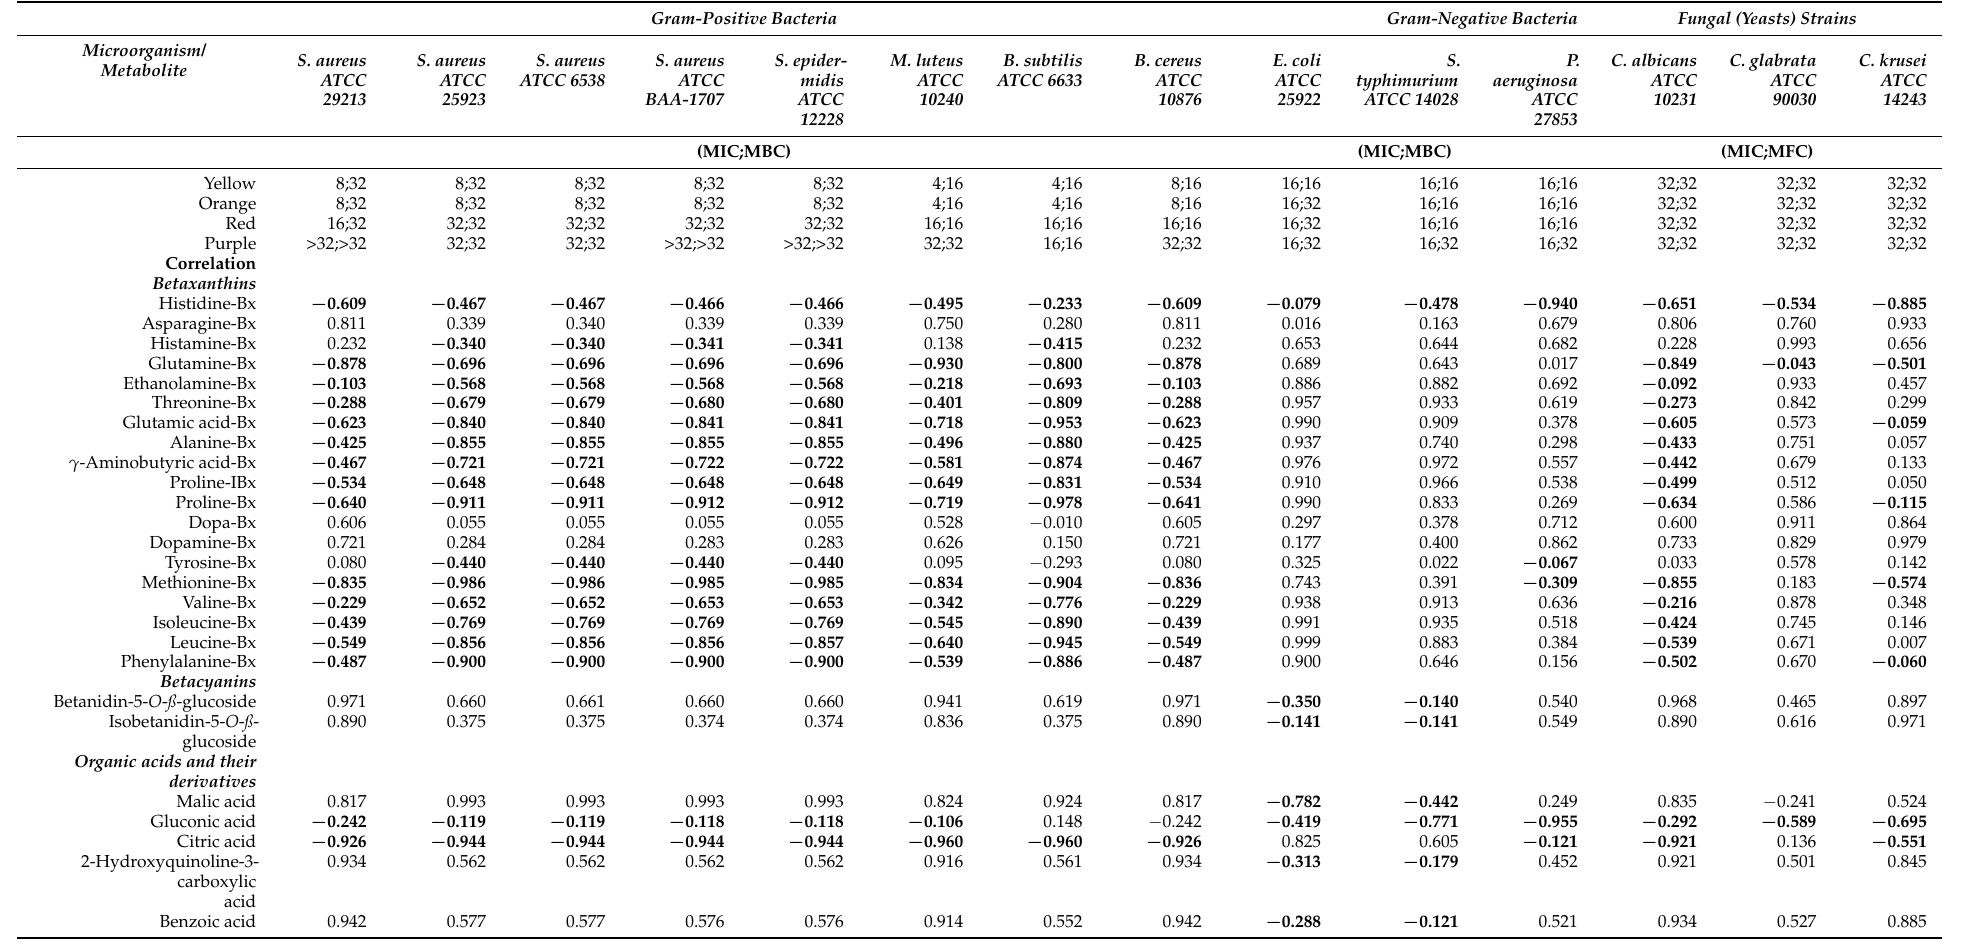
Table 4. Antimicrobial activity of extracts from the yellow, orange, red and purple flowers of Portulaca grandiflora assessed for their MIC (minimum inhibitory concentration), MBC (minimum bactericidal concentration), MFC (minimum fungicidal concentration) and correlation coefficients between identified metabolites (absolute peak areas) and microbial activity (MIC